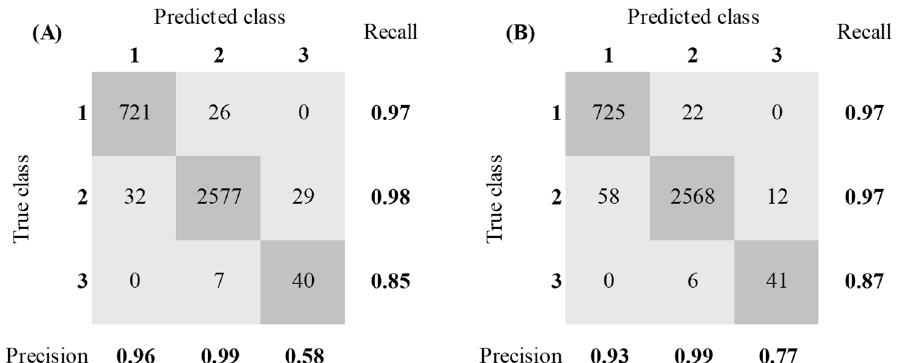
Figure 6. Confusion matrix of the Random Forest model ( A ) and the Bagged Trees model ( B ) with dataset B as input data and no PCA applied. (Class 1 = static behavior, class 2 = semi-dynamic behavior, class 3 = high-dynamic behavior).